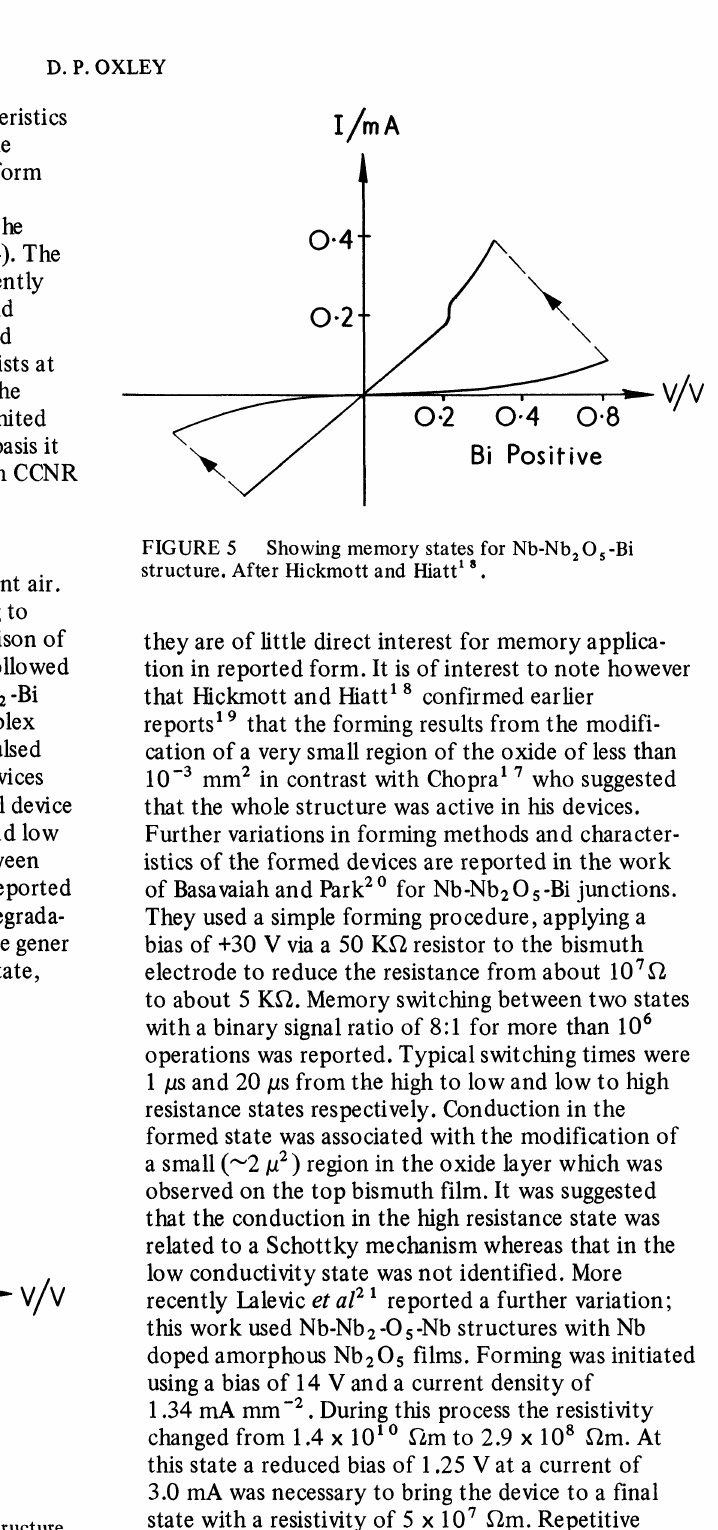
Showing CCNR in Nb-Nb oxide-Au structure. After Chopra 17.